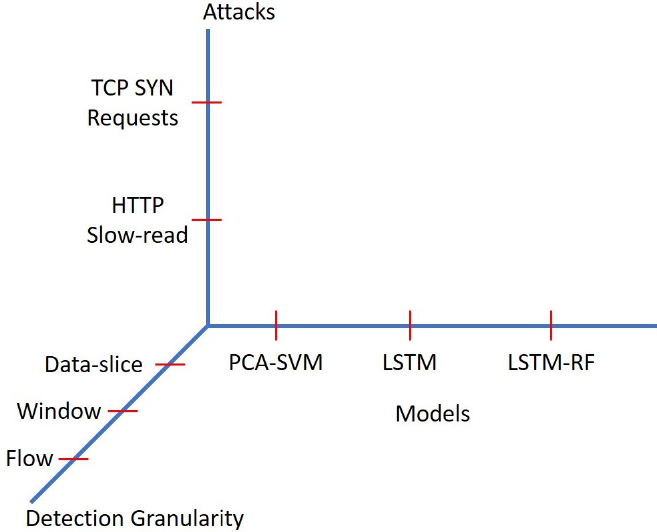
Figure 2. Attacks and models